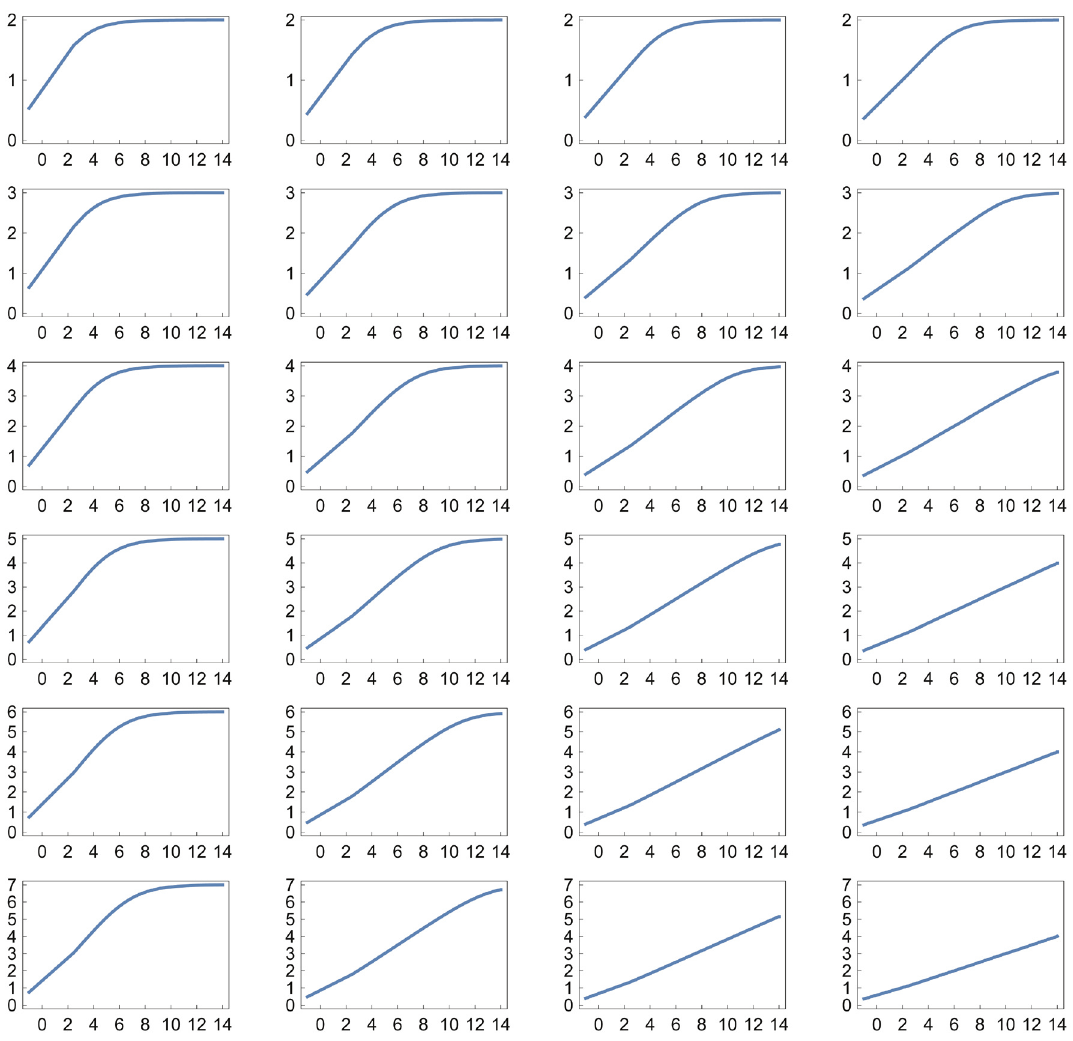
Figure 2. The logarithmic sensor response as in Figure 1, with the rows from top to bottom showing n = 1,2,3,4,5,6 and the columns from left to right showing b = 2,4,8,16. Note that the scale along the x -axis is increased to 2 14 compared with 2 12 in Figure 1. All plots use the Michaelis-Menten relation with Hill equation coefficient k = 1 (see Data